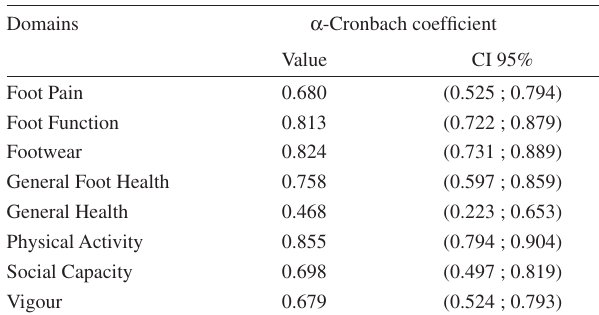
Table 4 - The α -Cron�ach coefficients for the analysis of the internal consistency of the domains of the FHSQ-Br Domains